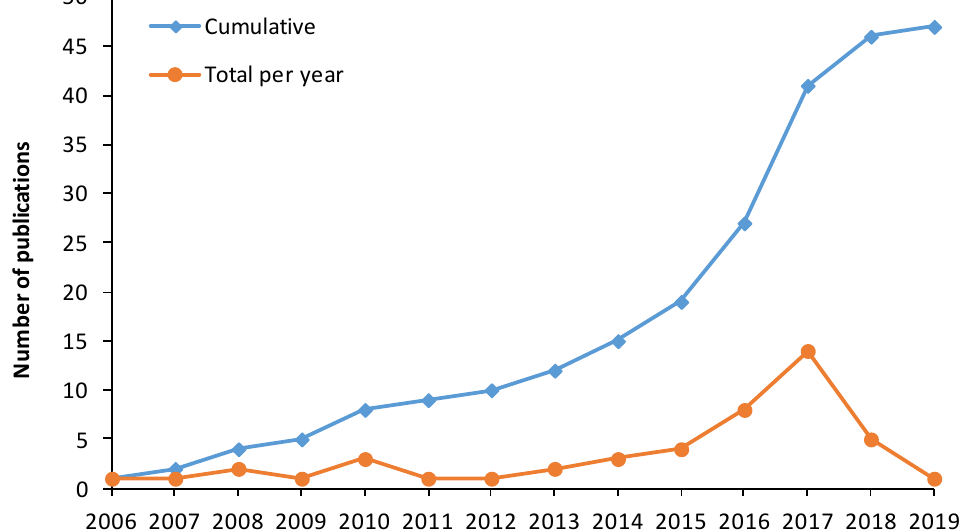
Figure 2. Peer-reviewed publications indexed in Scopus as of June 2019, wherein satellite images were used to detect looting at specific archaeological sites and/or image processing methods aimed to detect looting were presented.